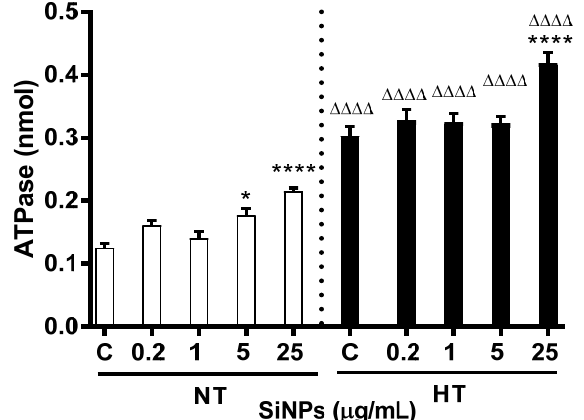
Figure 7. Effect of various concentrations ( µ g/mL) of silica nanoparticles (SiNPs) on ATPase activity measured in incubated erythrocytes of normotensive (NT) and hypertensive (HT) rats. Data are mean ± SEM ( n = 8 in each group). Statistical analysis by one-way analysis of variance (ANOVA) followed by the Holm–Sidak multiple comparisons test. * p < 0.05, **** p < 0.0001 vs. respective control and ∆∆∆∆ p < 0.0001 vs. respective concentration in NT